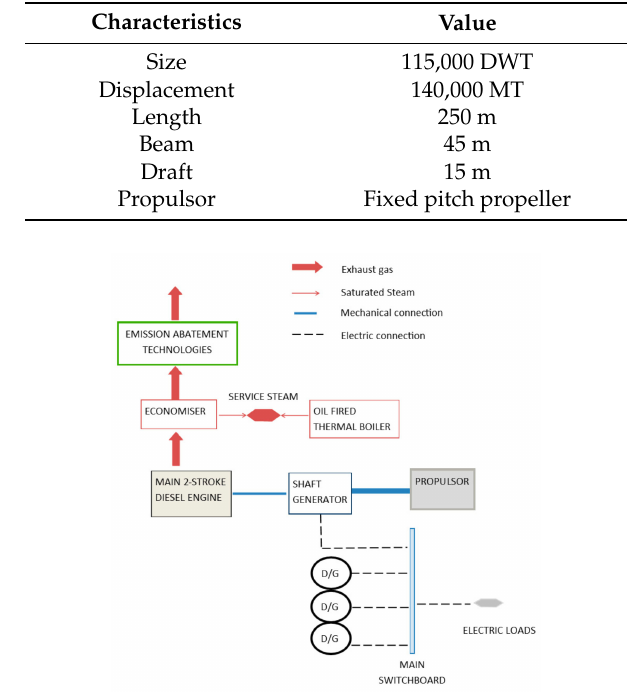
Figure 2. Aframax tanker power plant configuration layout. Table 2. Technologies considered for the Aframax